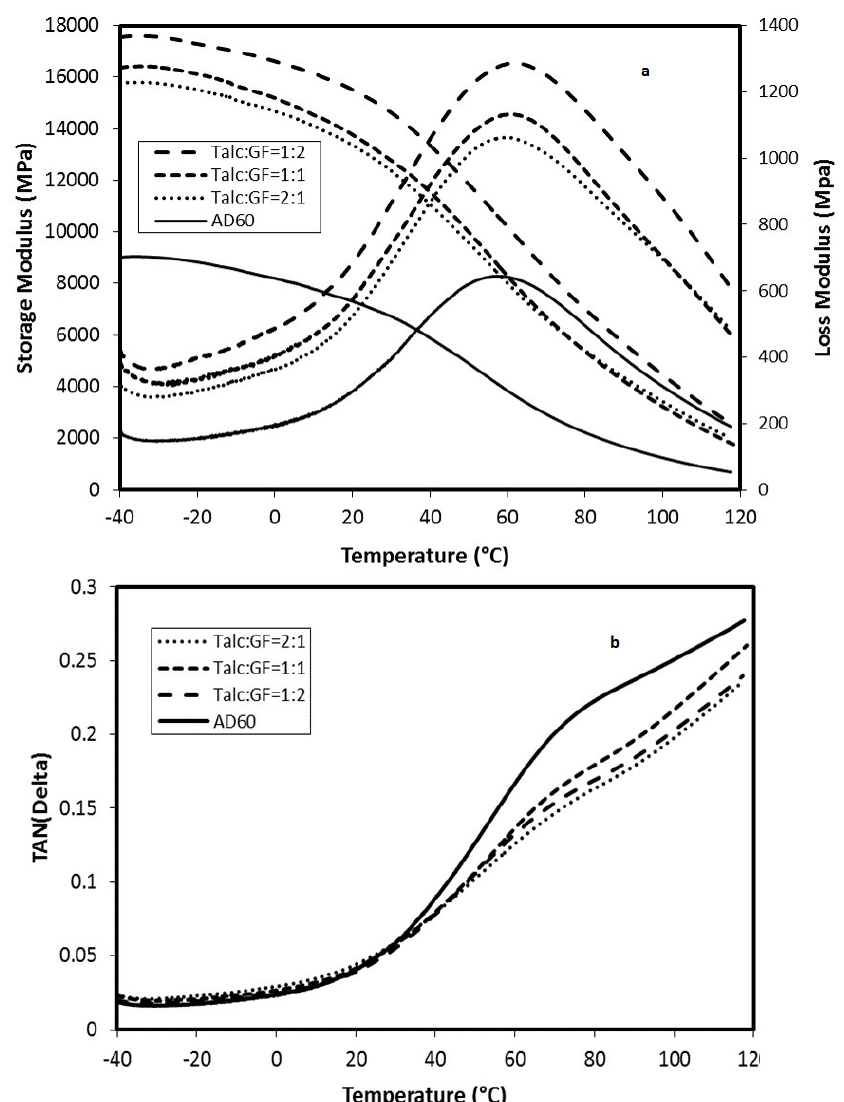
Figure 7. Effects of temperature level on storage modulus and loss modulus ( a ) and damping factor; ( b ) of HDPE AD60 composites filled with combined GF and talc fillers at the 30 wt